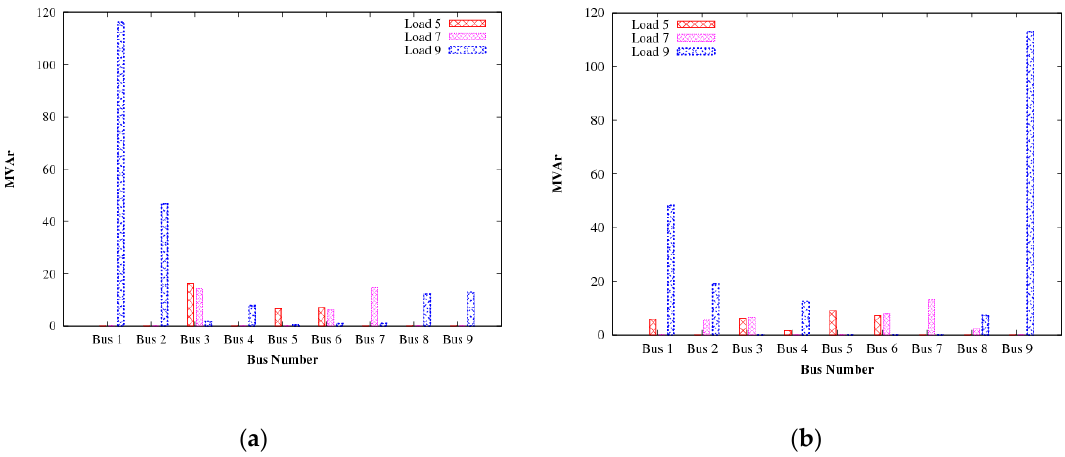
Figure 8. Allotment of reactive power production in each load: ( a ) without SVC; ( b ) with SVC.